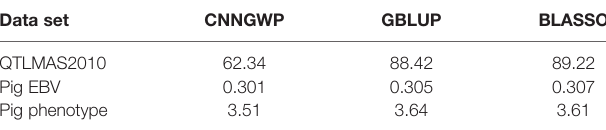
TABLE 2 | Test mean squared error (MSE) for CNNGWP, GBLUP, and BLASSO for each of the three data sets. Data set